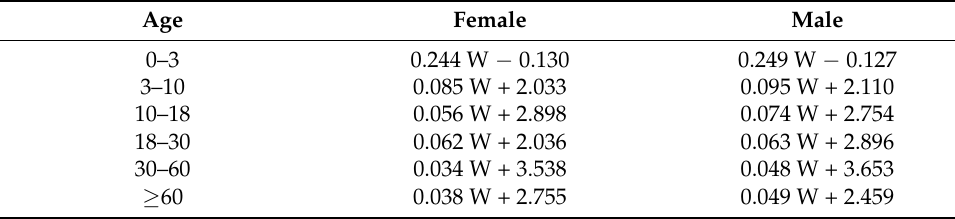
Table 2. Schofield BMR values (W is body mass in units of kg) [24].